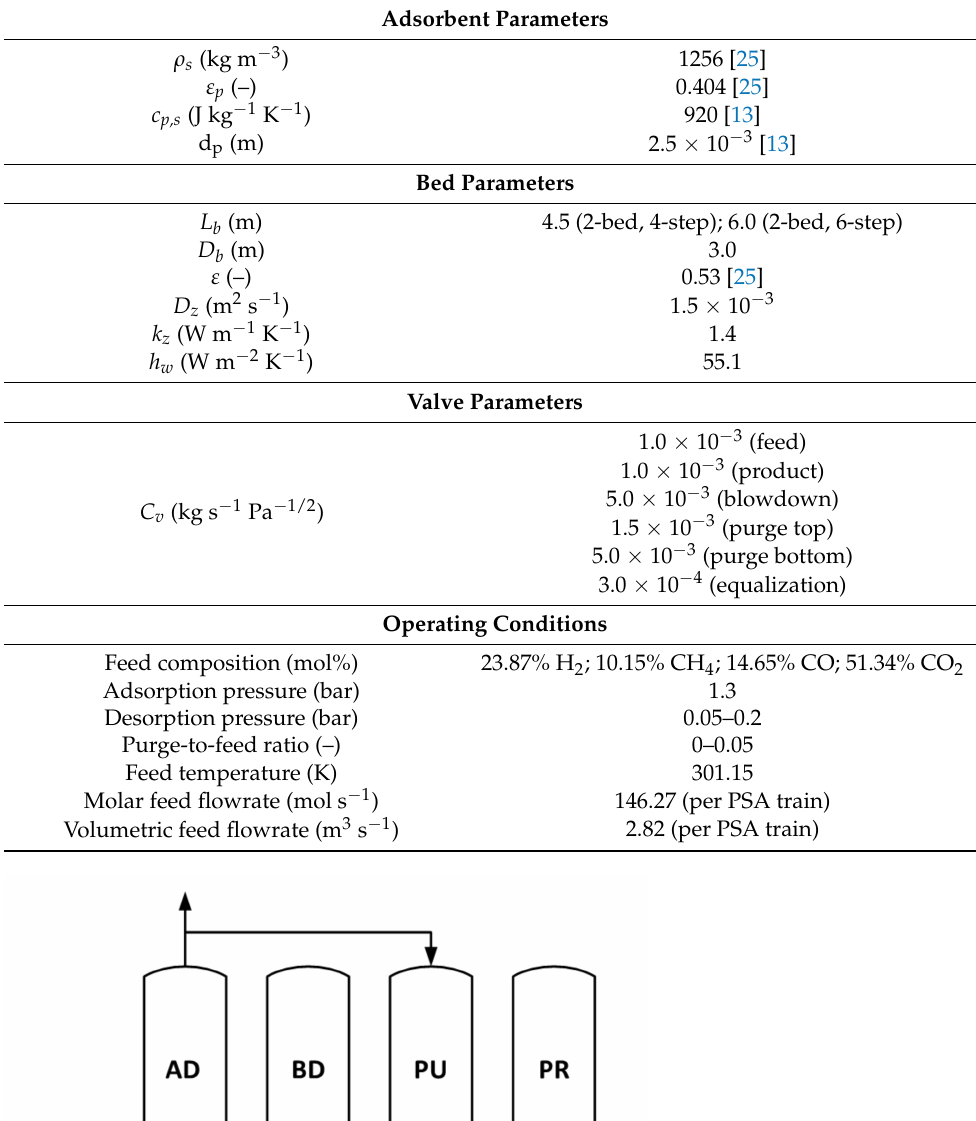
Table 2. Adsorbent parameters, bed parameters, valve parameters and operating conditions for the VPSA process.